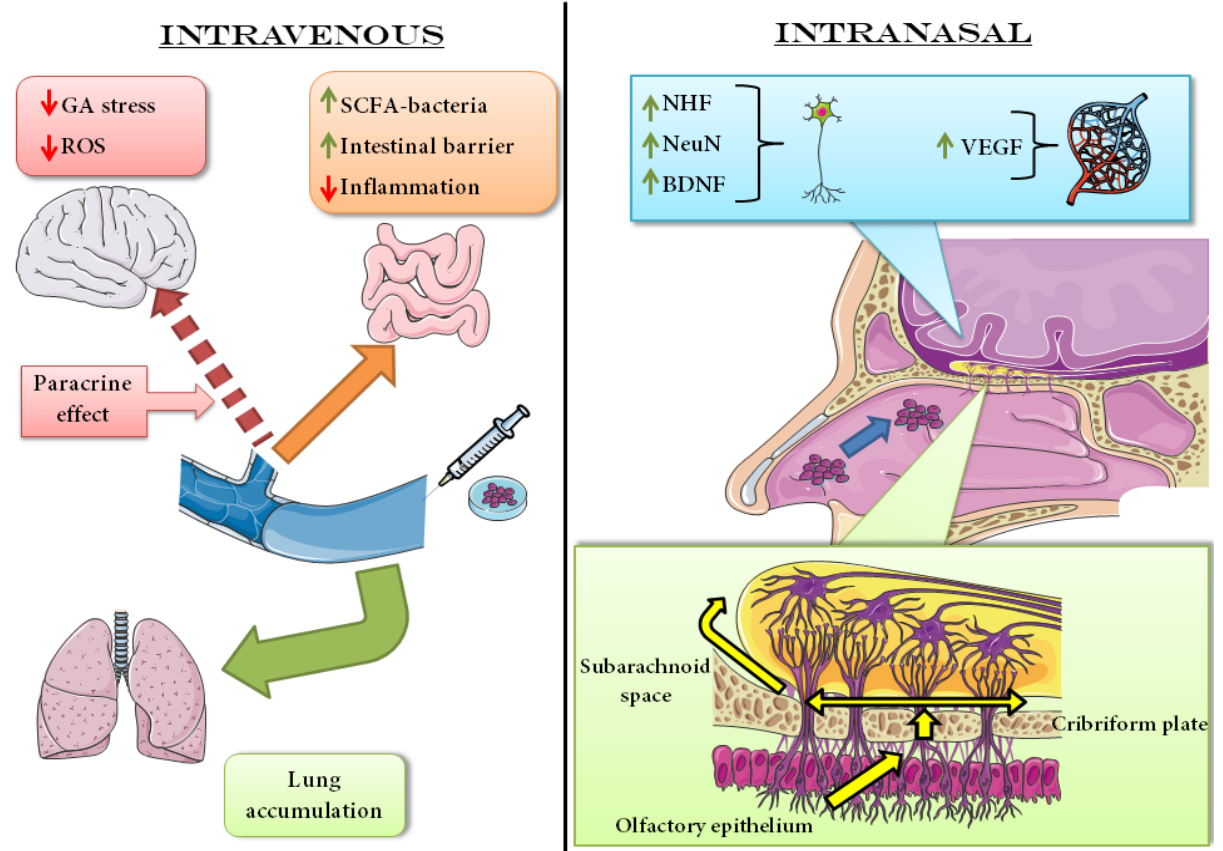
Figure 2. Schematic representation of the stem cells’ effects when injected intravenously or intranasally. In the first case, the cells tend to accumulate in the lungs, but they are able to exert their effect on other organs, such as the intestine and brain. Intranasal administration allows the cells to cross the olfactory epithelium, the cribriform plate, and then into the subarachnoid space, where the CSF will distribute the cells across the brain. In this situation, the stem cells increase the neurogenesis and the angiogenesis, obtaining the double effect of neuron recovery and blood flow restoration.